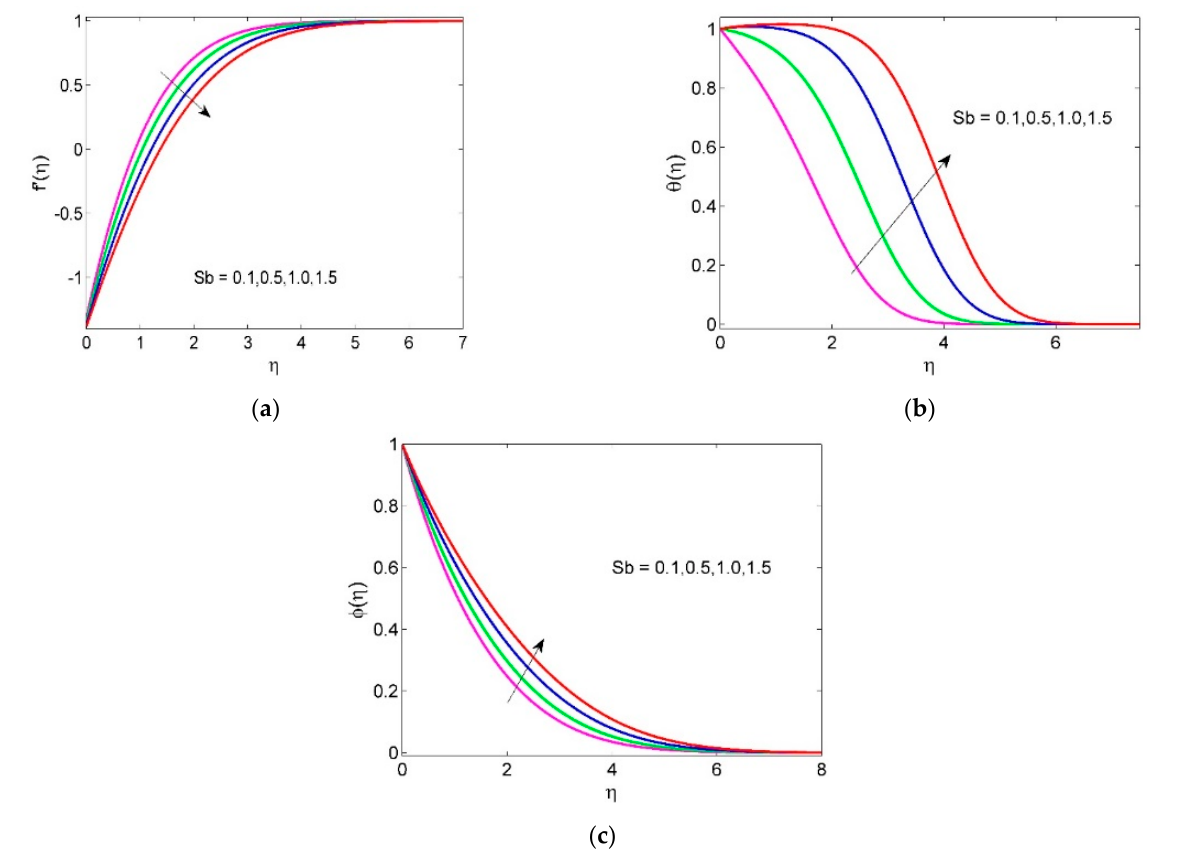
0.254321 From Figure 2a, rising Stefan blowing decreases the velocity profile. Infer that an up- surge in Stefan blowing from the surface to free stream which slows down the speed of HNF as it moves towards the surface due to mass diffusion. With the upsurge of Stefan